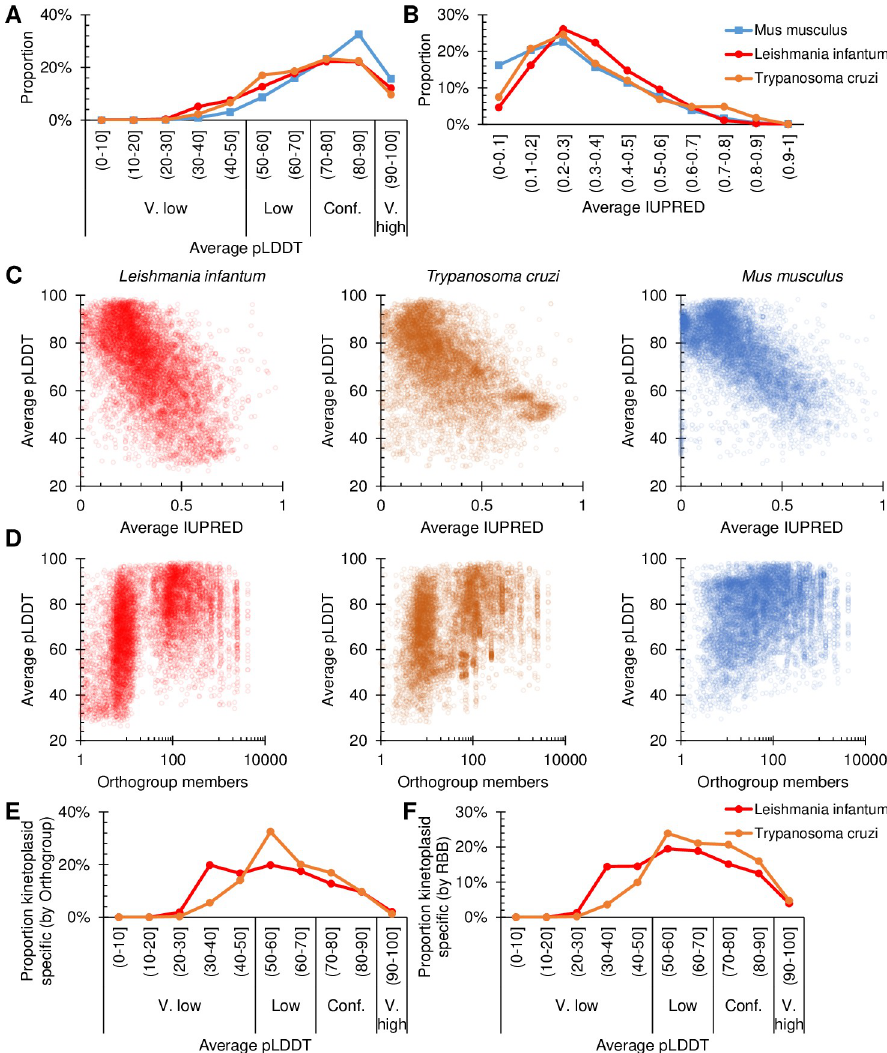
Fig 1. Proteome-wide quality of protein structure predictions of kinetoplastid proteins in comparison to mouse proteins in the AlphaFold database. A) Distribution of per-protein average pLDDT for all L . infantum (7924), T . cruzi (19024) and, for comparison, M . musculus (21588) proteins, from the AlphaFold database [1, 4]. Scores for very low, low, confident and very high confidence categories are the same as used on the website. B) Distribution of per- protein average IUPred score for the same three species. C) Correlation of per-protein average pLDDT with IUPred score for the same three species. D) Correlation of per-protein average pLDDT with number of orthologs (total number of orthogroup members determined from a diverse set of eukaryotes, see Methods). A random number between 0 and 1 was added to each ortholog count to better represent point density at low ortholog numbers. E,F) Distribution of per-protein average pLDDT for all L . infantum and T . cruzi proteins lacking an ortholog outside of the kinetoplastids, as determined by either E) orthogroup members only in kinetoplastid species (1509 and 7181 proteins respectively) or F) reciprocal best protein sequence search hits only in kinetoplastids species (2361 and 11723 proteins respectively).